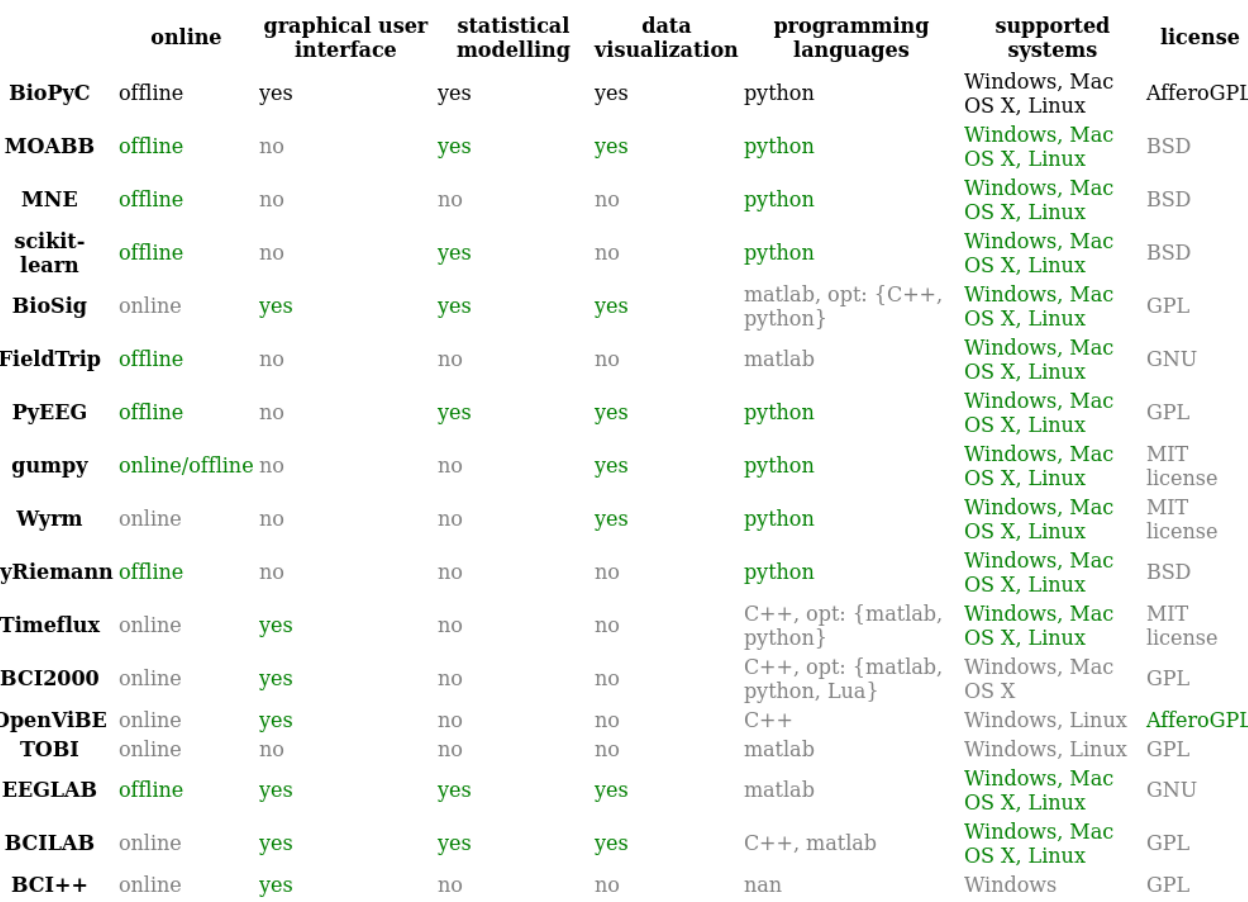
Figure 2. Comparison of main features of existing toolboxes having modules for EEG signals processing and classification. BioPyC values for each feature are written in black; values of features that are similar to those of BioPyC are written in green; and finally, values of features that differ from those of BioPyC are written in grey. “opt” stands for “optional” in the